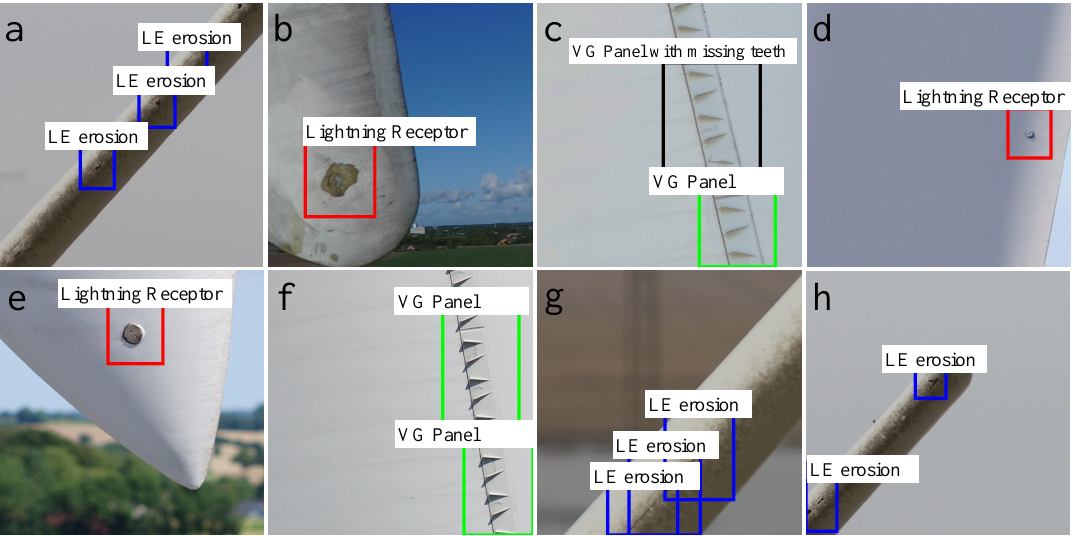
Figure 2. Examples of manually-annotated damages related to wind turbine blades. LE, Leading